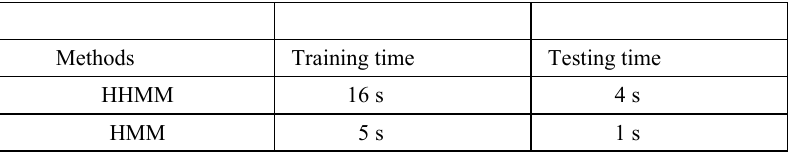
Fig. 3. Comparison testing results. Table 1. Training time and testing